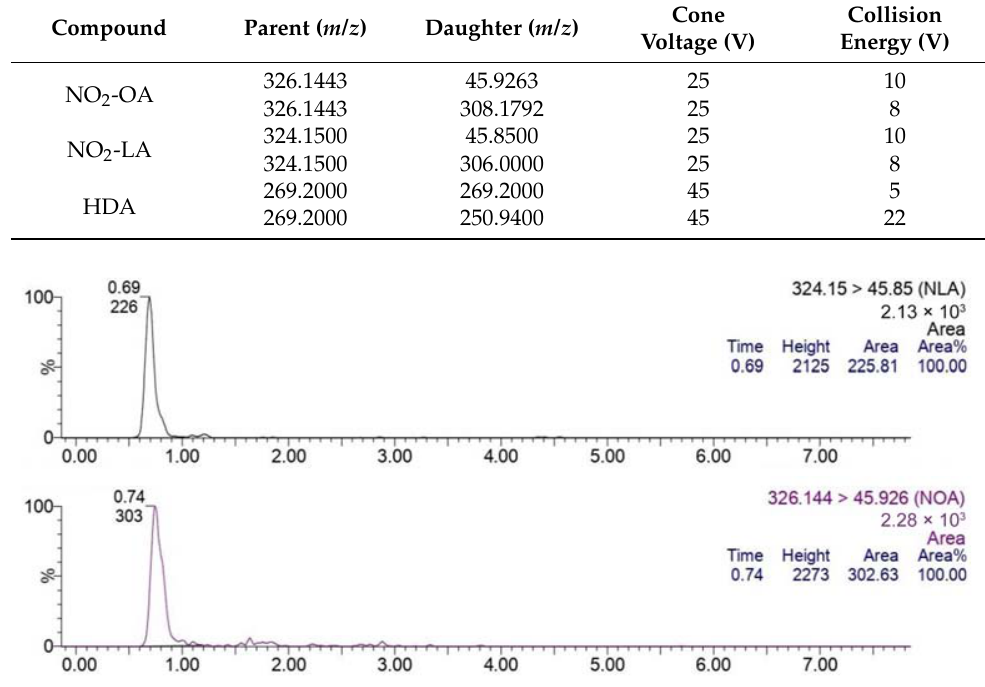
Figure 2. Mass transitions used for quantification of NO 2 -LA (top) and NO 2 -OA (bottom) in extracted plasma using reversed phase UPLC-MS/MS, mobile phase: H 2 O and ACN containing 0.05% NH 4 OH.